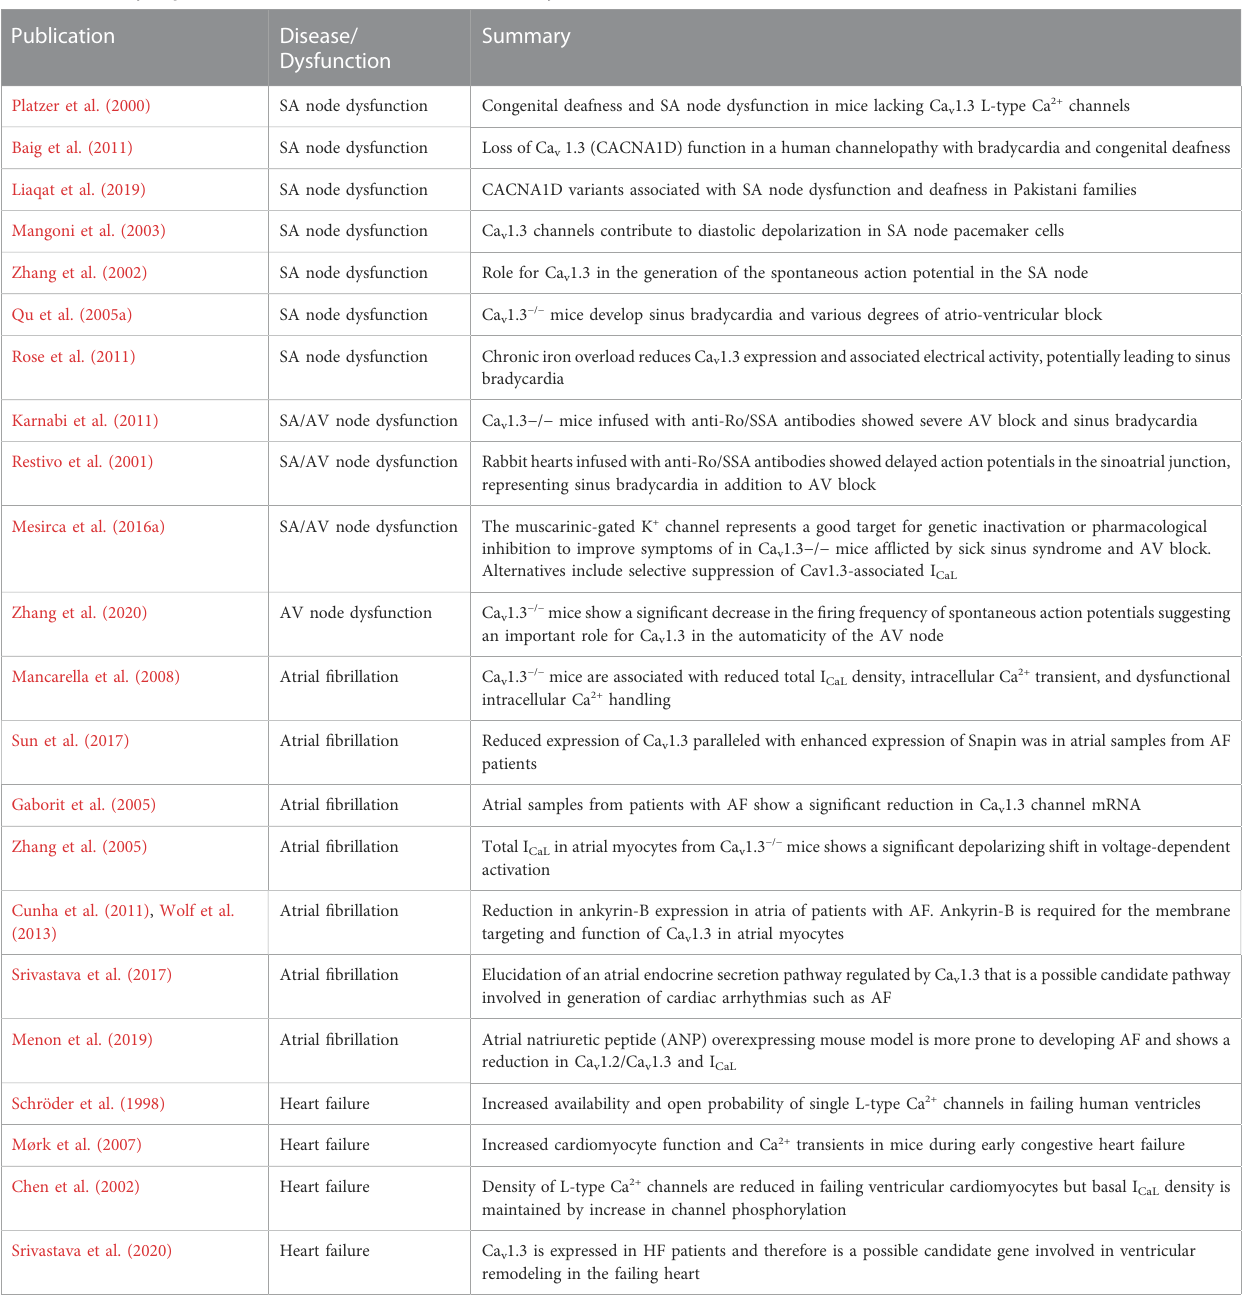
TABLE 1 Summary of published literature on Ca v 1.3 in SA/AV node dysfunction, atrial fi brillation, and heart